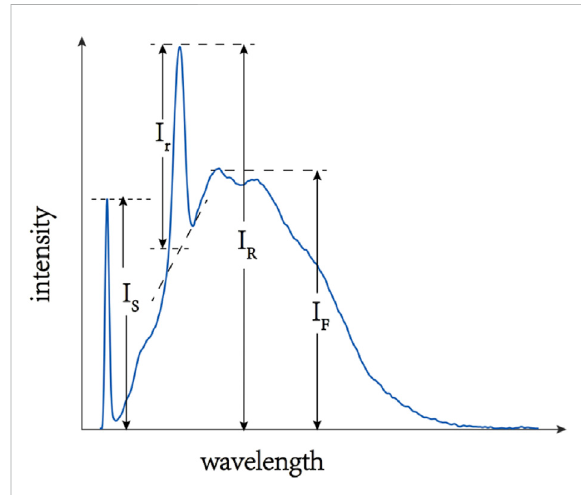
FIGURE 1 A typical spectrum produced by laser exciting water ( I S is Rayleigh-scattered and Mie-scattered laser signal generated by elastic scattering, I r is the intensity of water Raman signal by deducting the fl uorescence background, I R is water Raman signal generated by inelastic scattering, I F is DOM fl uorescence